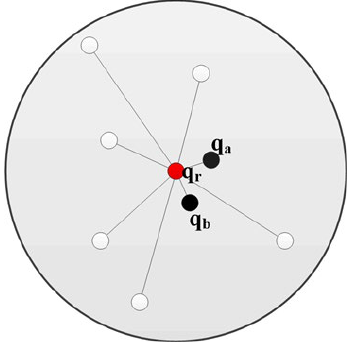
7 of 22 Figure 3. Schematic diagram of FPFH neighborhood.